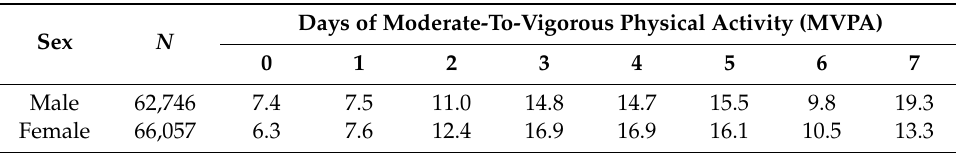
Table A1. Unadjusted distribution (%) of days of 60 min of MVPA by sex. Days of Moderate-To-Vigorous Physical Activity Sex N